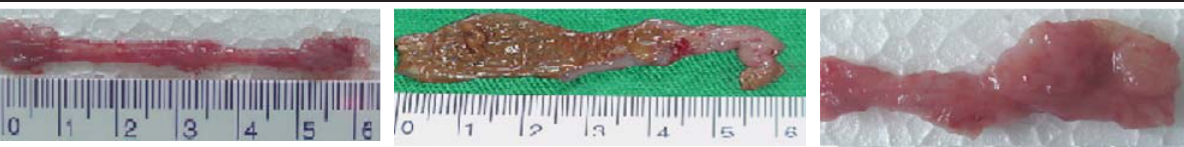
FIGURE 3 - Macroscopic Evaluation - longitudinal sections of colorectal segment. a- Normal appearance (non-Colitis Group) b- Main lesion extends for more than 4 cm along the colon (Colitis Group-day 7) c- Bowel wall thickening (Colitis Group-day 14)